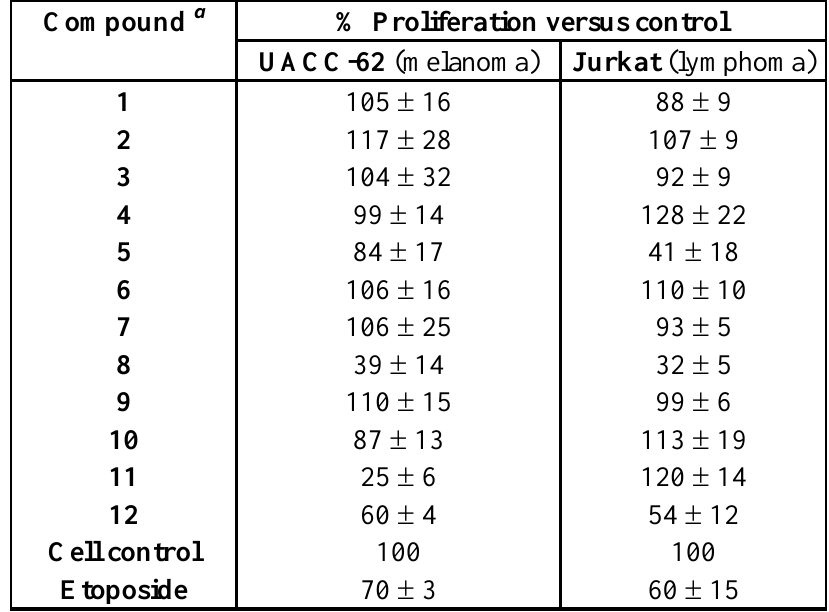
Table 1. Effects of compounds synthesized on the growth of human cancer cells lines UACC-62 and